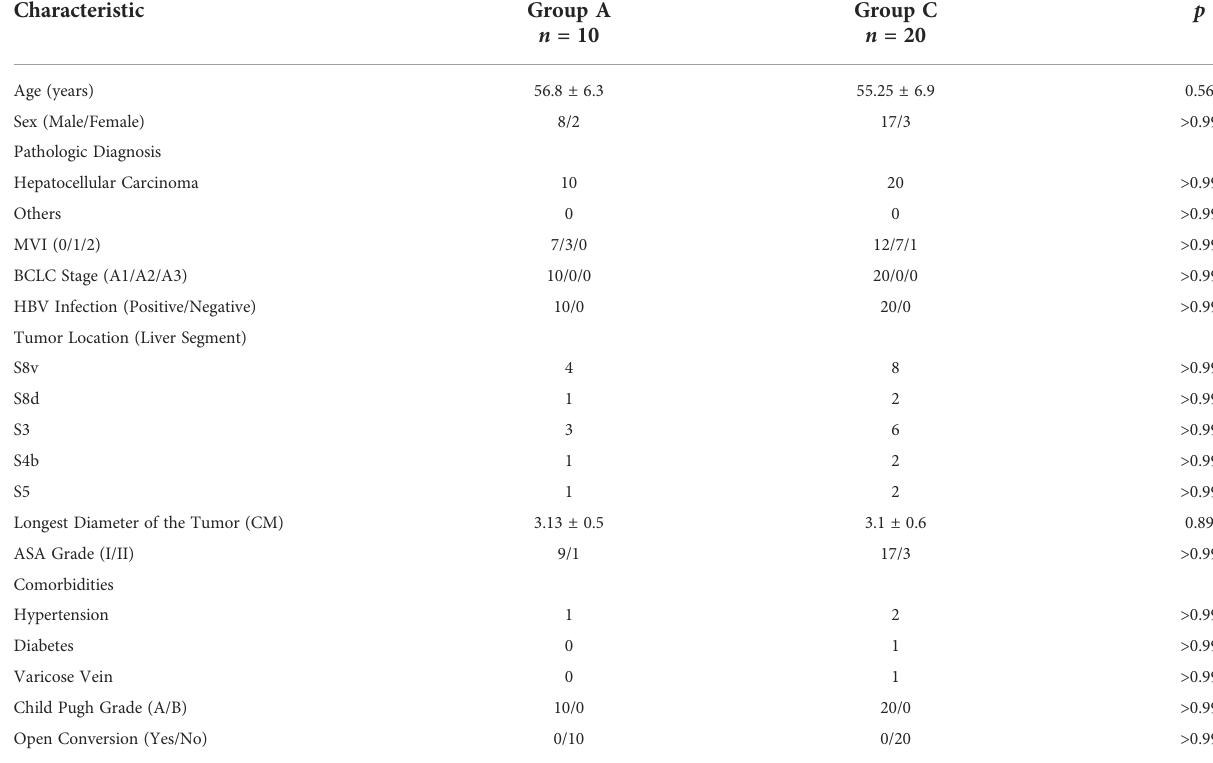
TABLE 1 Basic characteristics of HCC patients in Group A and Group C after PSM.